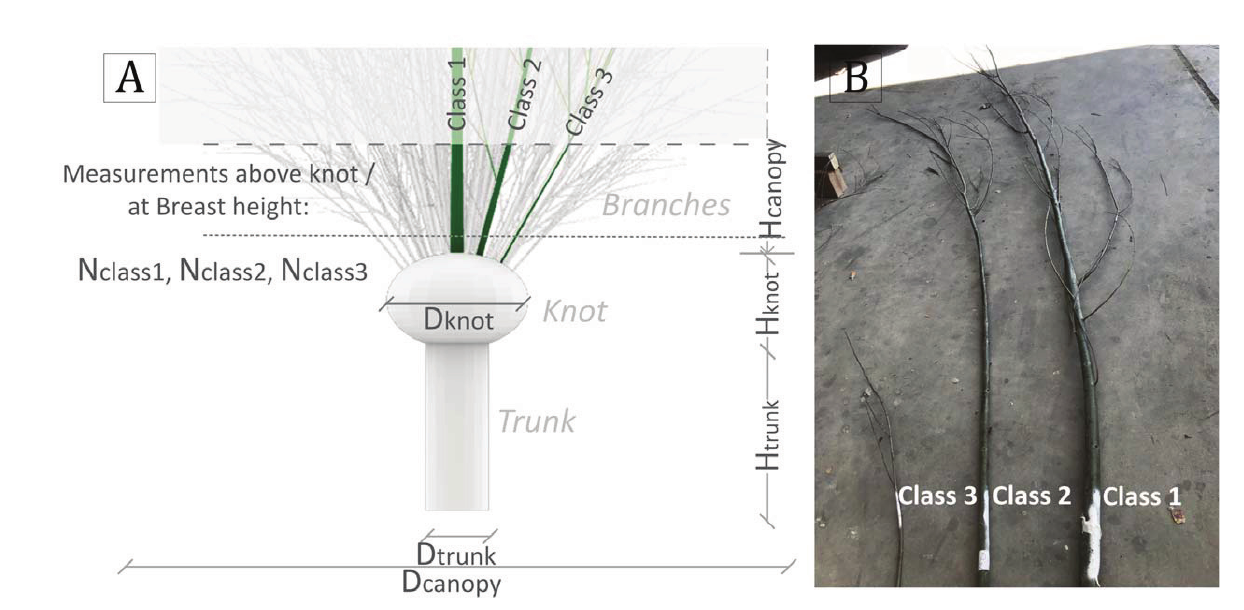
FIGURE 2 | (A) General tree characteristics of the pollard willow, (B) examples of the 3 different diameter classes of